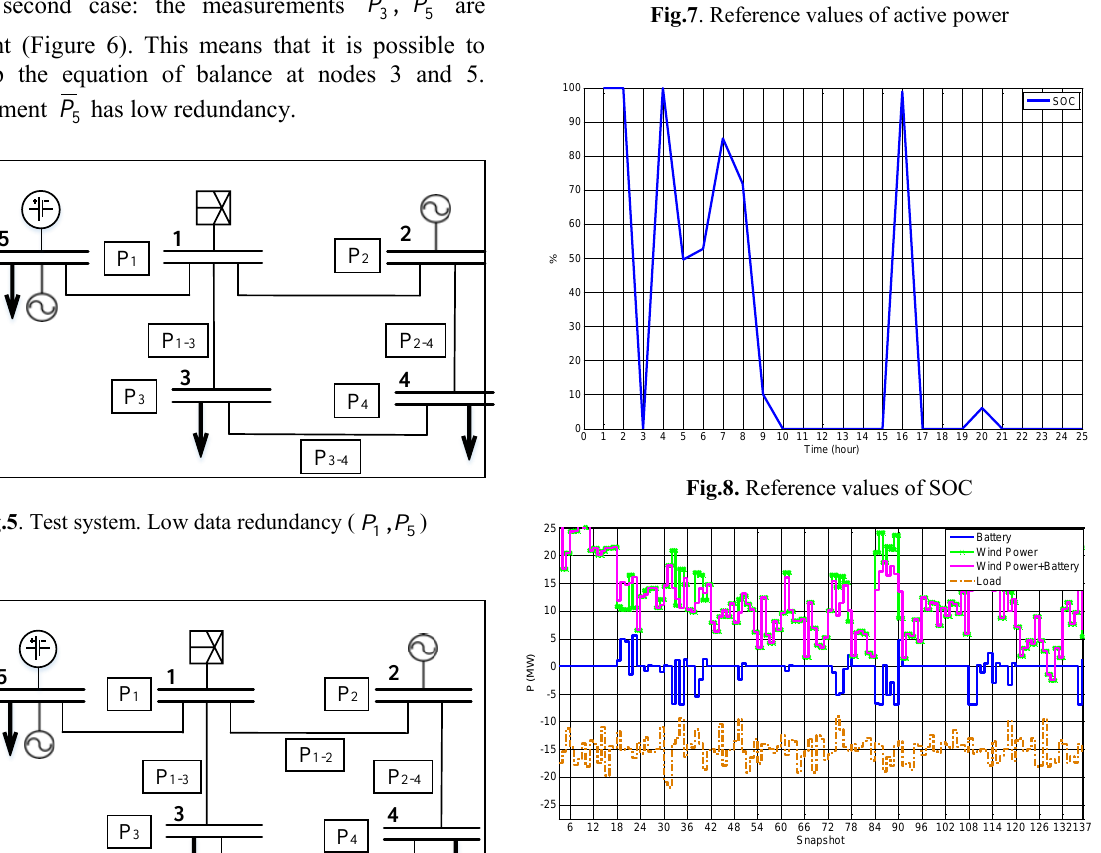
Fig.9. Curves of active power measurement (at the battery –